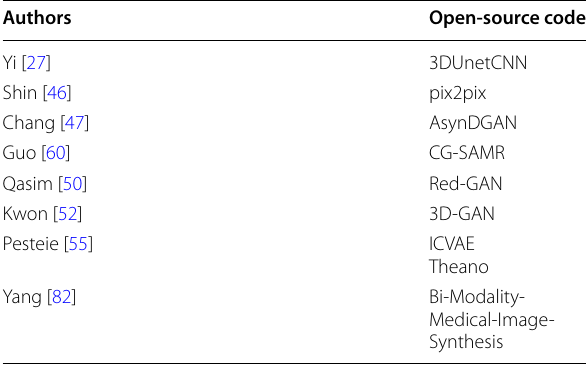
Table 7 Studies with available open-source code on GitHub